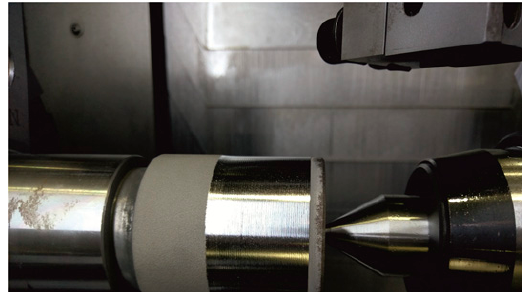
Figure 5. Machining of Stellite 6.